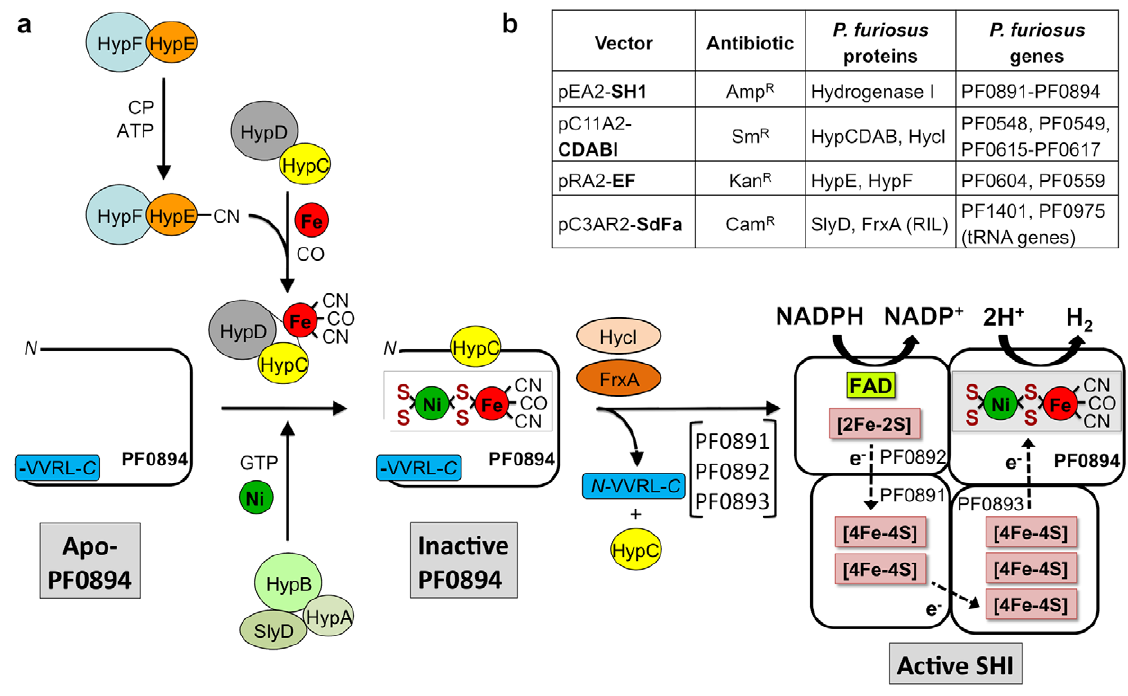
Figure 1. Synthesis of P.furiosus soluble hydrogenase I (SHI) and the plasmid constructs used for recombinant production. ( a ) Maturation pathway for the [NiFe] catalytic site of P. furiosus SHI is based on that proposed for E. coli hydrogenase 3 [10]. HypE and HypF generate thiocyanate in an ATP-dependent process from carbamoyl phosphate (CP). The source of the CO ligand is unknown. The HypCD complex binds the iron atom containing the CN and CO ligands and donates it to the catalytic subunit (PF0894). The Ni atom is provided by the HypAB-SlyD complex in a GTP-dependent reaction. The Ni and Fe atoms in the [NiFe] site are coordinated to PF0894 by the S atoms of four of its Cys residues (indicated by S). Activation of PF0894 requires cleavage of four C-terminal residues (-VVRL) catalyzed by a newly identified peptidase, FrxA (and to a much lesser extent by HycI). It is not known how the biosynthesis of PF0894 is coordinated with that of the other three subunits (PF0891, PF0892 and PF0893) to give catalytically-active SHI. The predicted cofactor content of mature heterotetrameric SHI [11] is shown together with their roles in the reversible production of hydrogen gas from NADPH. The abbreviations used are: CP, carbamoyl phosphate; CO, carbonyl ligand; CN, cyano ligand; FAD, flavin adenine dinucleotide. ( b ) The expression plasmids utilized for production of SHI in E. coli strain MW4W. The antibiotics refer to the selective marker on each plasmid: Amp, Ampicillin; Sm, Streptomycin; Kan, Kanamycin; Cam, Chloramphenicol.